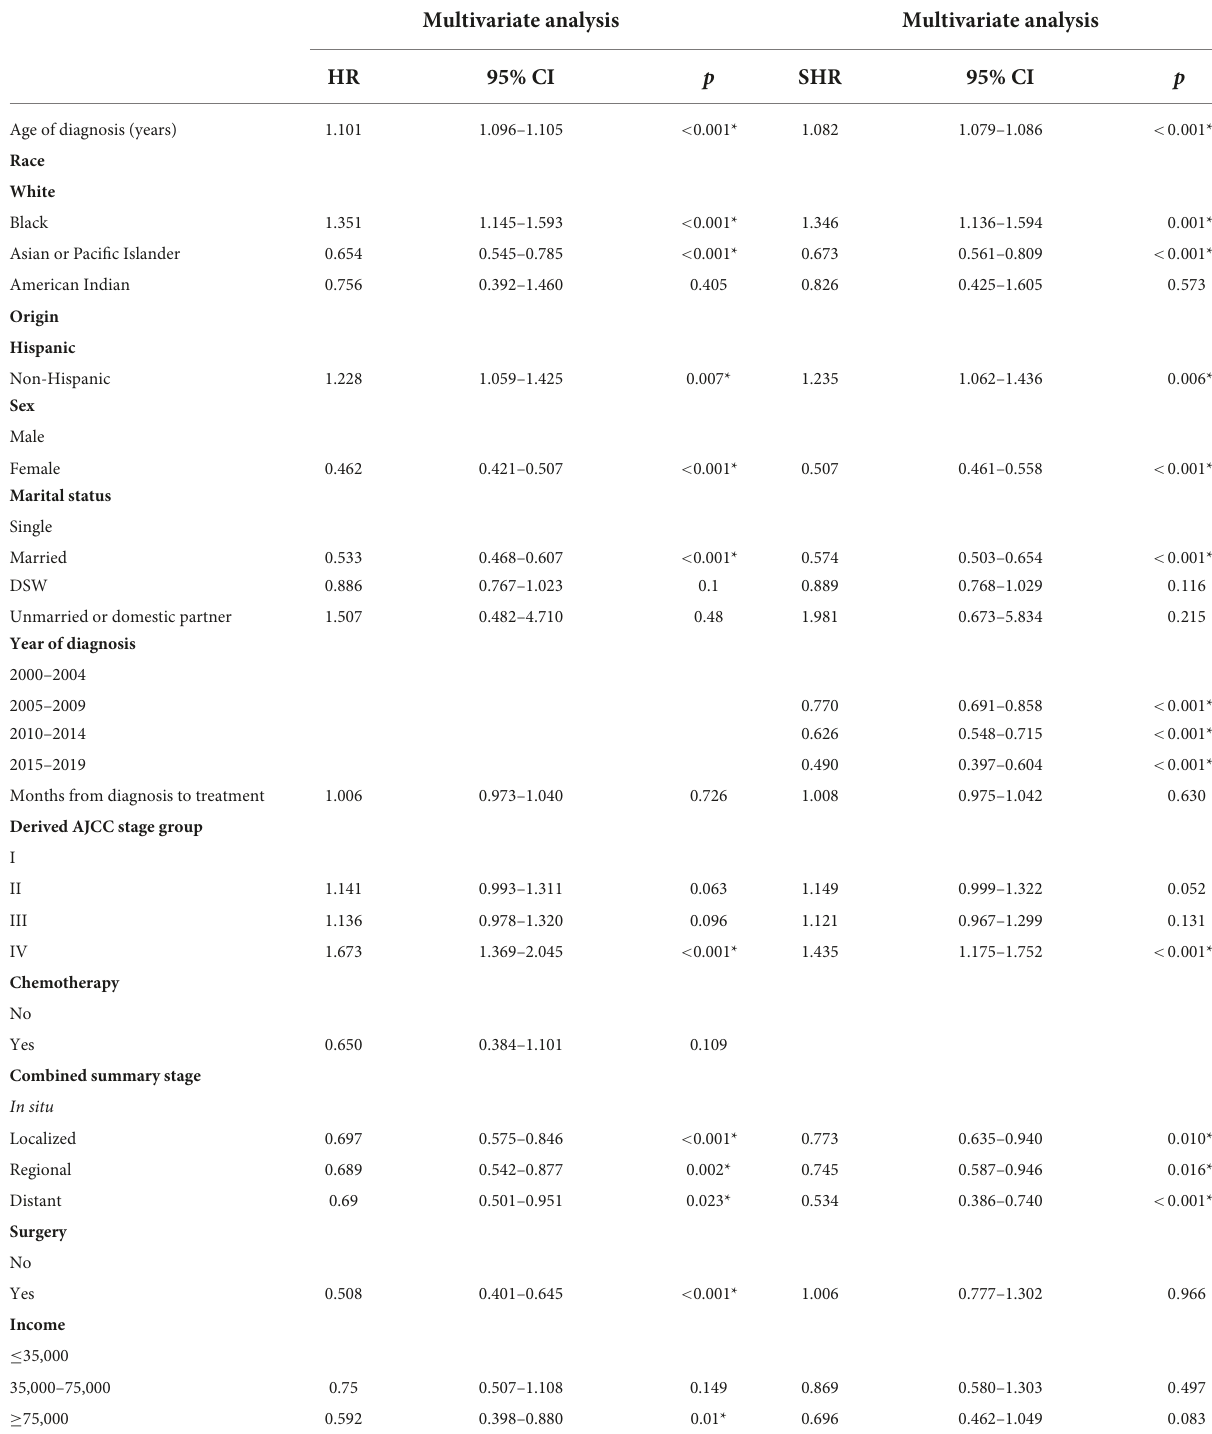
TABLE 3 Multivariate regression analyses after propensity score